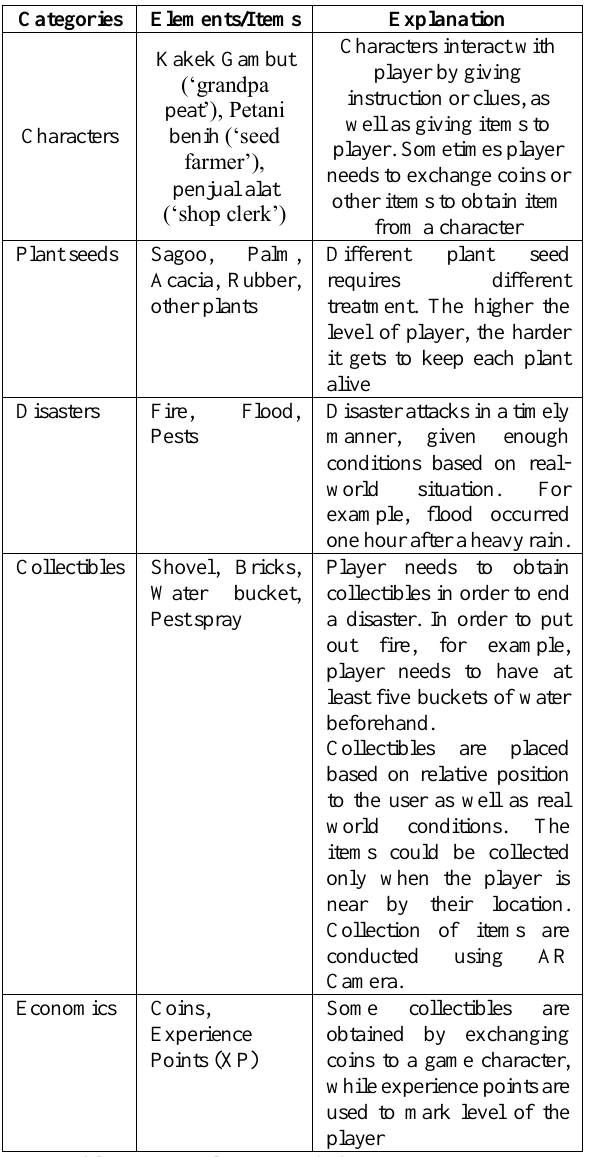
Table 2. Game Elements and Their Representations